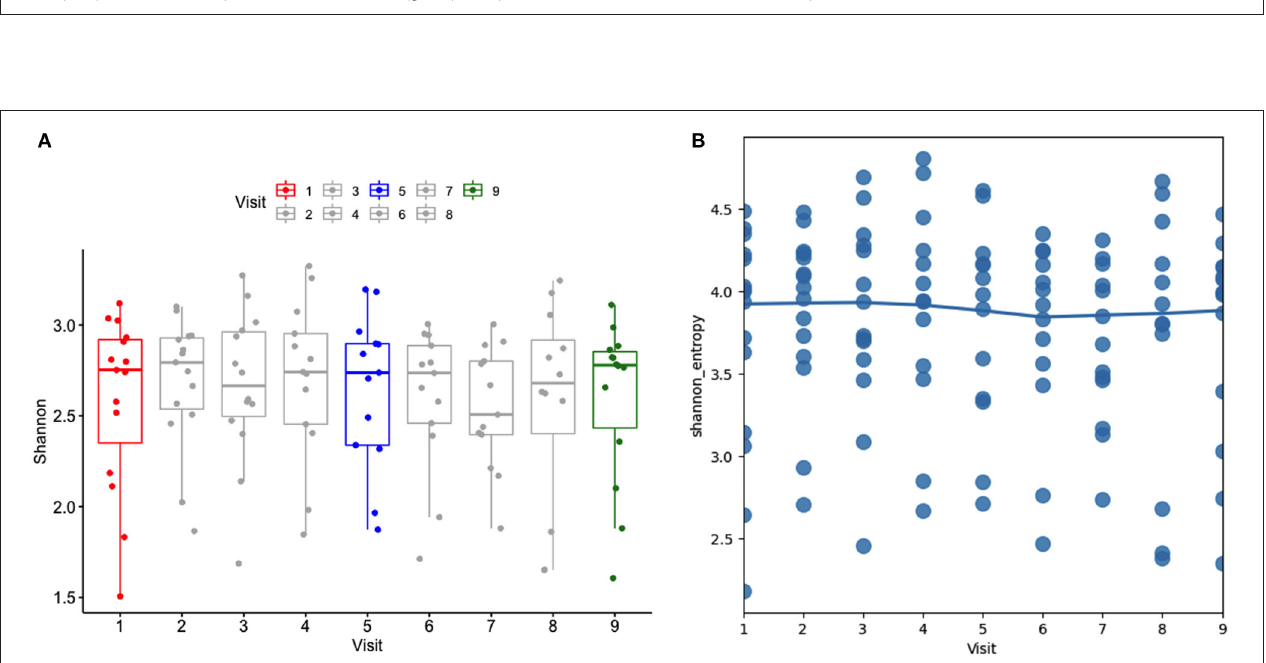
FIGURE 2 | (A) Alpha diversity using the Shannon index at different stages (visits). Visit 1(red): baseline, visit 5 (blue): end of 2-week probiotic trial, and visit 9 (green): samples taken 3 weeks after cessation of the probiotic. (B) Regression scatter plot linear mixed effects model of alpha diversity demonstrating the trend of data.